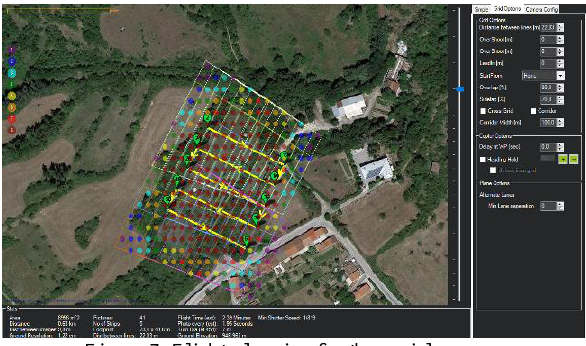
Figure 7. Flight planning for the aerial